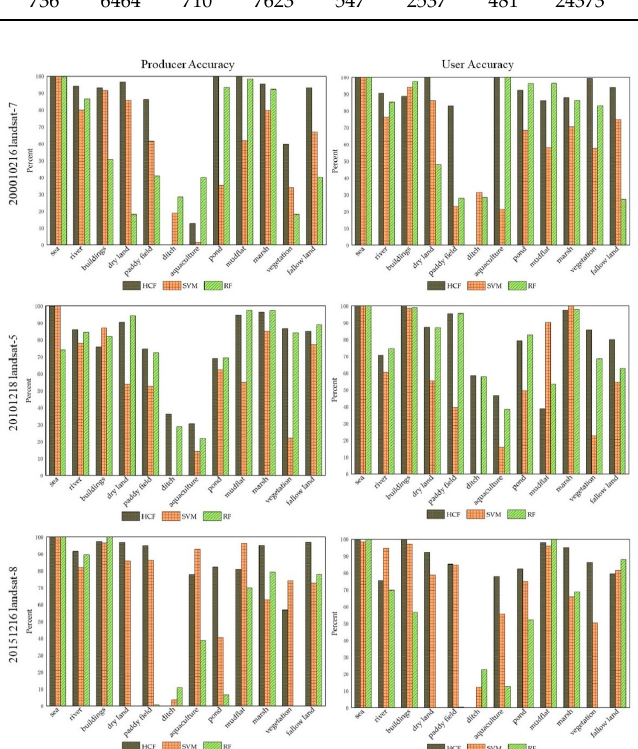
Figure 6. Classification Maps of HCF, SVM and RF on Yancheng coastal wetland Landsat data.